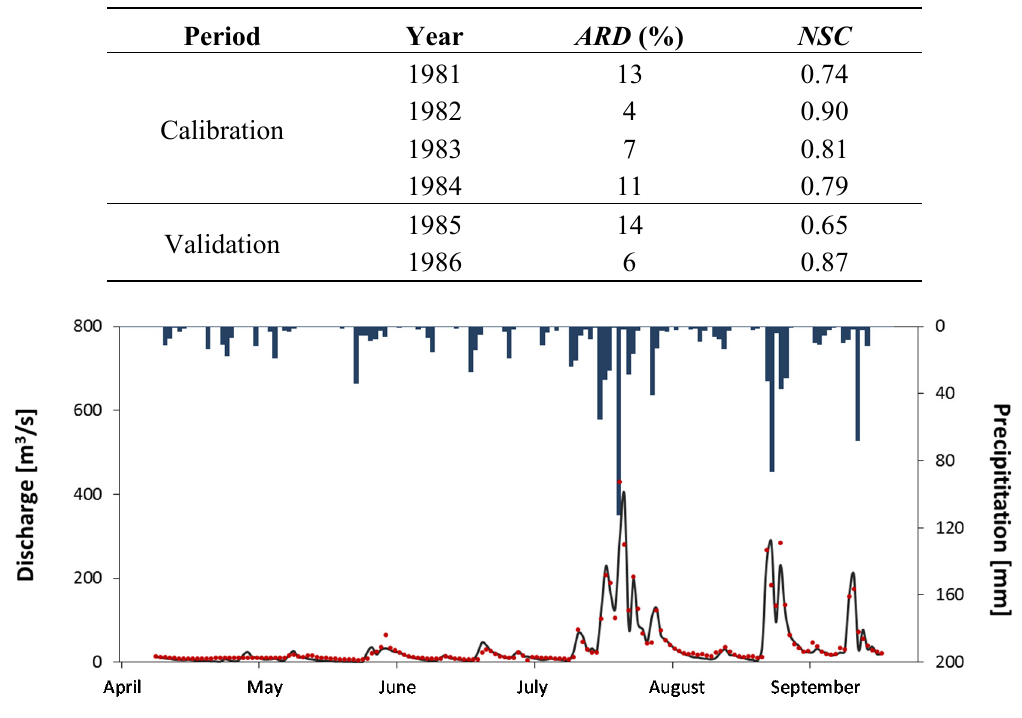
Figure 3. An illustration of the model performance of the Grid-Xinanjiang model with the subgrid parameterization in the Yanduhe Basin in 1986. Red dot, observed discharge; black line, simulated discharge; blue bar,